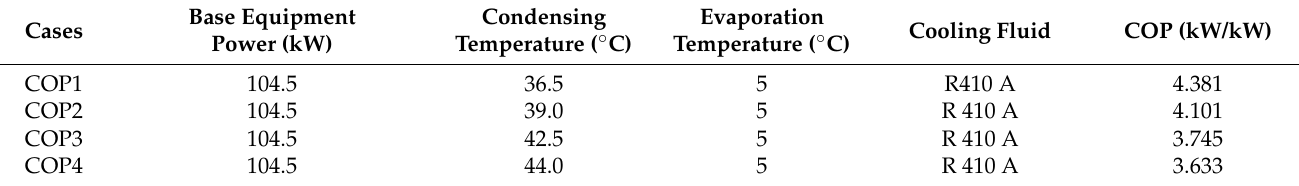
Table 4. Distribution of electricity consumed in a DC.